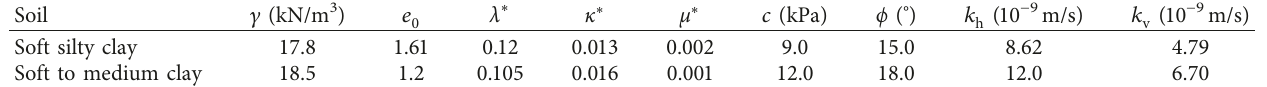
Table 1: Summary of the geotechnical properties of subsoil.